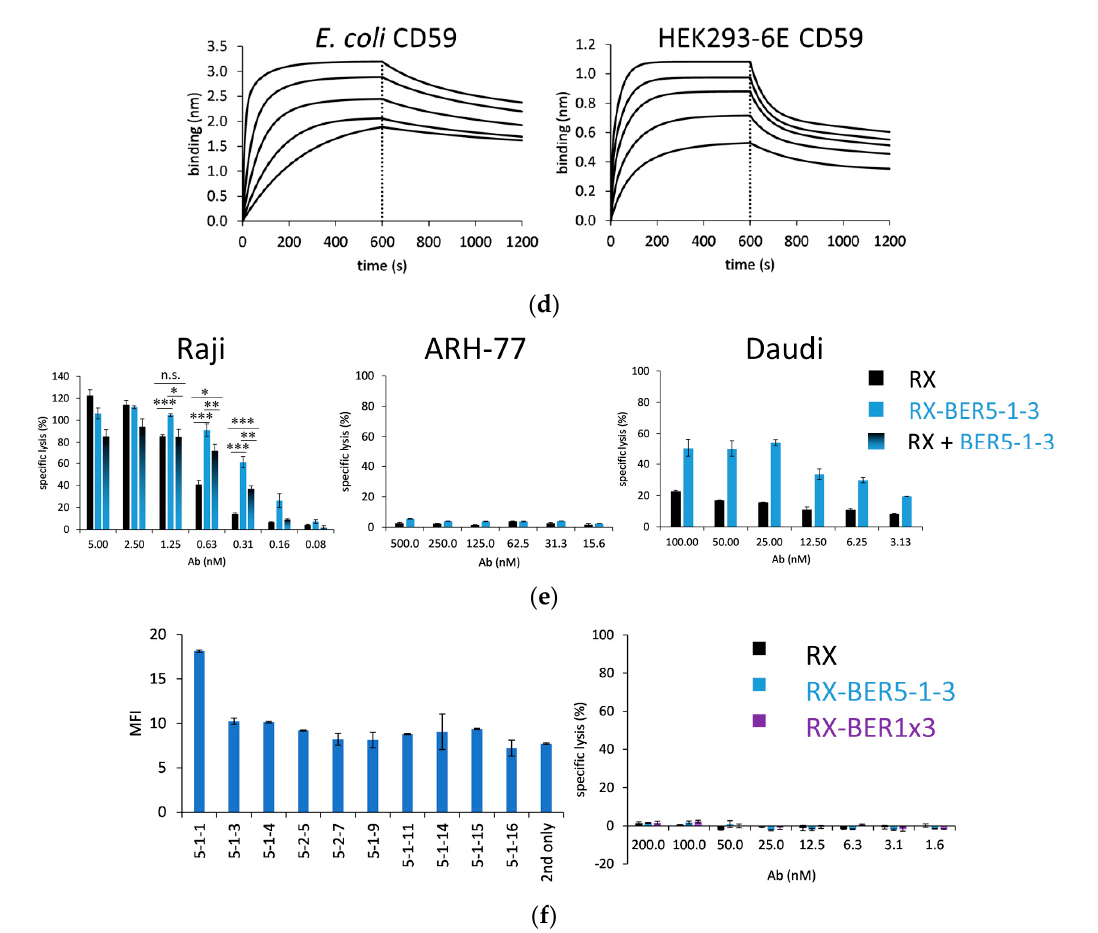
Figure 6. BER1x3-derived clones from libraries BER1x3_4NNK and BER1x3_5NNK, selected with mammalian cells-derived CD59 antigen: ( a ) ELISA response of rituximab (RX)-based mAb 2 molecules to HEK-expressed CD59 and mouse serum albumin as a control antigen; ( b ) Complement-dependent cytotoxicity (CDC) assay of RX-based bispecific antibodies on Raji cells, compared with parental clone RX-BER1x3, in 2-fold dilutions starting from 5 nM, decreasing concentrations are presented from dark to light blue (sample size n = 2, mean and S.D. are shown); ( c ) Profiles of RX-derivates in SEC-HPLC in native conditions (MWS: molecular weight standard); ( d ) Biolayer interferometry-measured response of RX-BER5-1-3 to bacterially expressed and refolded CD59 (left panel) and mammalian cells expressed CD59 (right panel), in 2-fold dilutions starting from 300 nM; ( e ) Comparison of the CDC effect of RX and RX-BER5-1-3 on Raji cells (left panel), ARH-77 cells (central panel) and Daudi cells (right panel) (sample size n = 3 for experiments done with Raji and n = 2 for ARH-77 and Daudi, one-way ANOVA was used to determine the significance (n.s. (not significant) 0.05 ≤ p , * 0.01 ≤ p < 0.05, ** 0.001 ≤ p < 0.01, *** 0.0001 ≤ p < 0.001), mean and S.D. are shown; ( f ) SK-BR-3 cell surface binding of RX-based mAb 2 molecules at 2 µM concentration (left panel) and the CDC (in)activity of RX and the mAb 2 derivates on this cell line, sample size n = 2 (right panel). Mean and S.D. are presented.